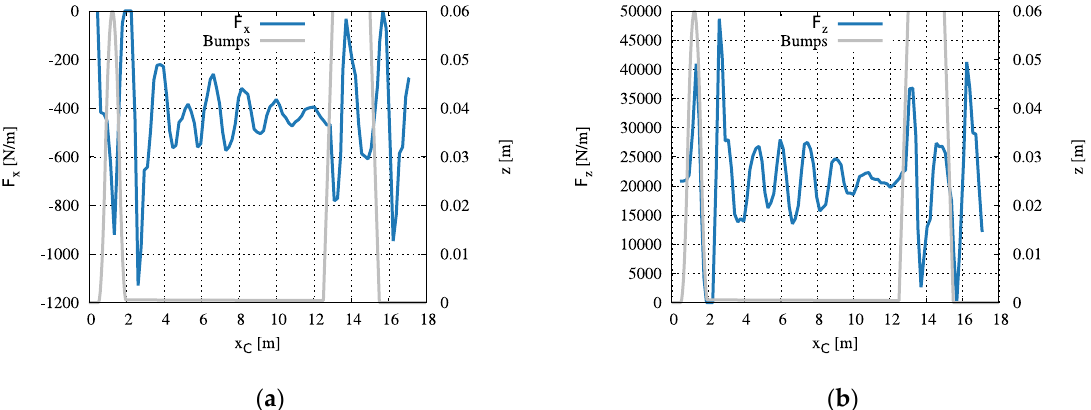
Figure 21. Courses obtained as a result of the computer simulations: ( a ) a course of coordinate from contact point 𝐶 , ( b ) rolling resistance force 𝐹 𝑥